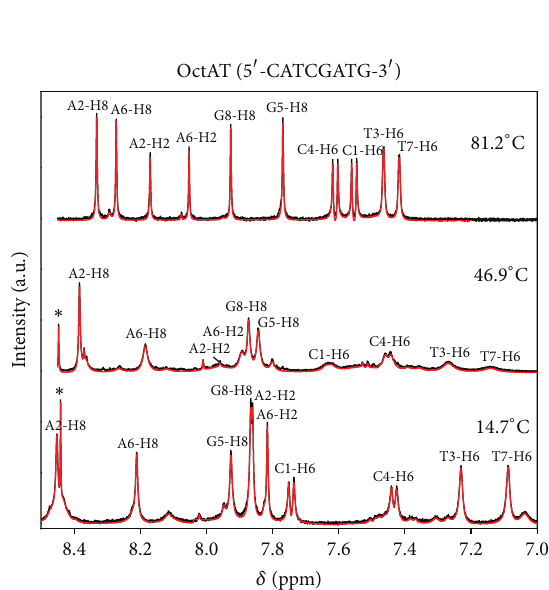
Figure 3: Example 1 H NMR spectra of OctAT in the region of nonexchangeable base hydrogen signals at temperatures when duplexes are formed (bottom), in the melting region (middle), and when only separated strands are present (top). Black lines show the experimental data and red ones the results of the fits (details in the text). The assignments of the NMR lines used for the melting temperature determination are denoted as the following: the type of the nucleobase, its position in the sequence from the 5 󸀠 side, and position of the hydrogen in respect of the purine or pyrimidine ring.